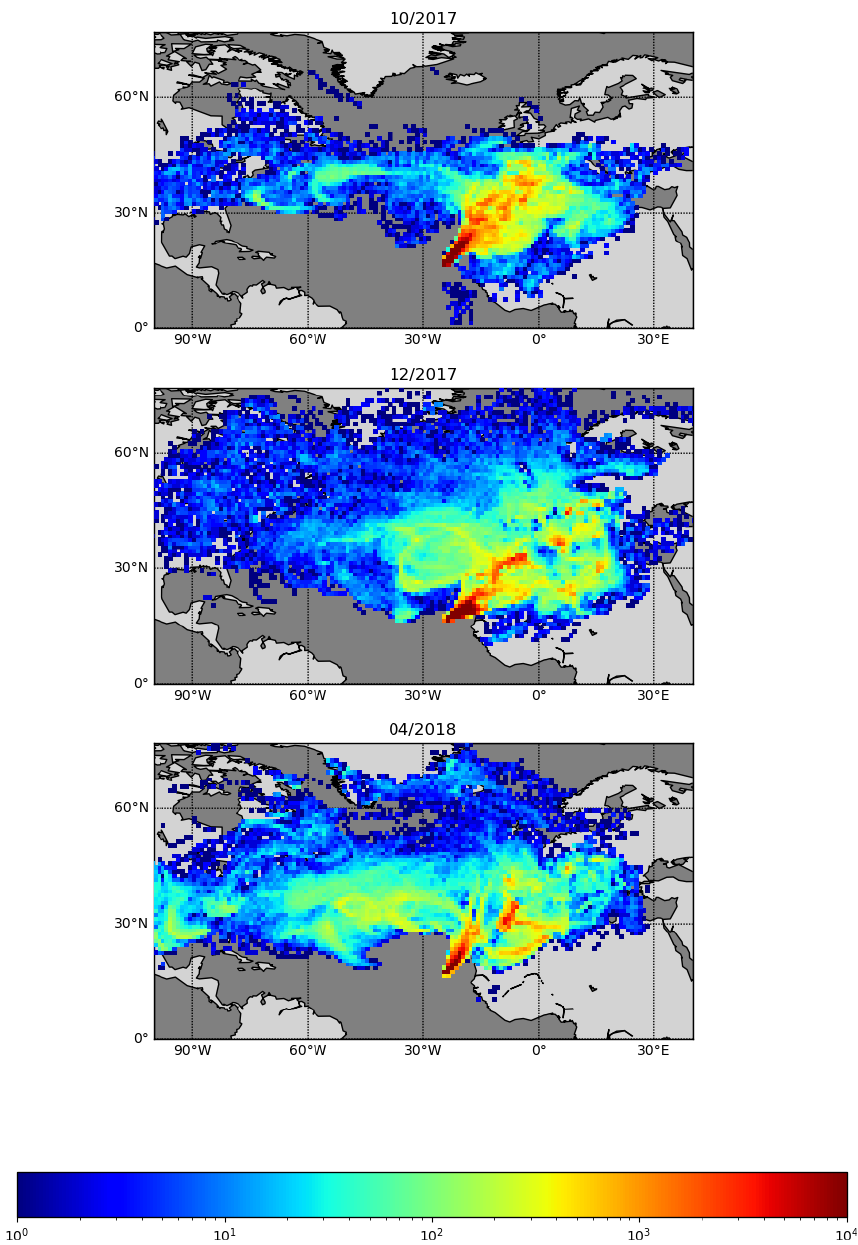
Figure 8. Back trajectories estimated for October 2017, December 2017, and April 2018. FLEXPART version 10.4 is used in backwards mode, driven by pressure level data from Global Forecast System (GFS) reanalyses at 0.5 ◦ × 0.5 ◦ resolution (Pisso et al., 2019; Stohl et al., 1998). The 10d back-trajectory simulations are initialized every 6h, releasing 1000 particles from the CVAO site.